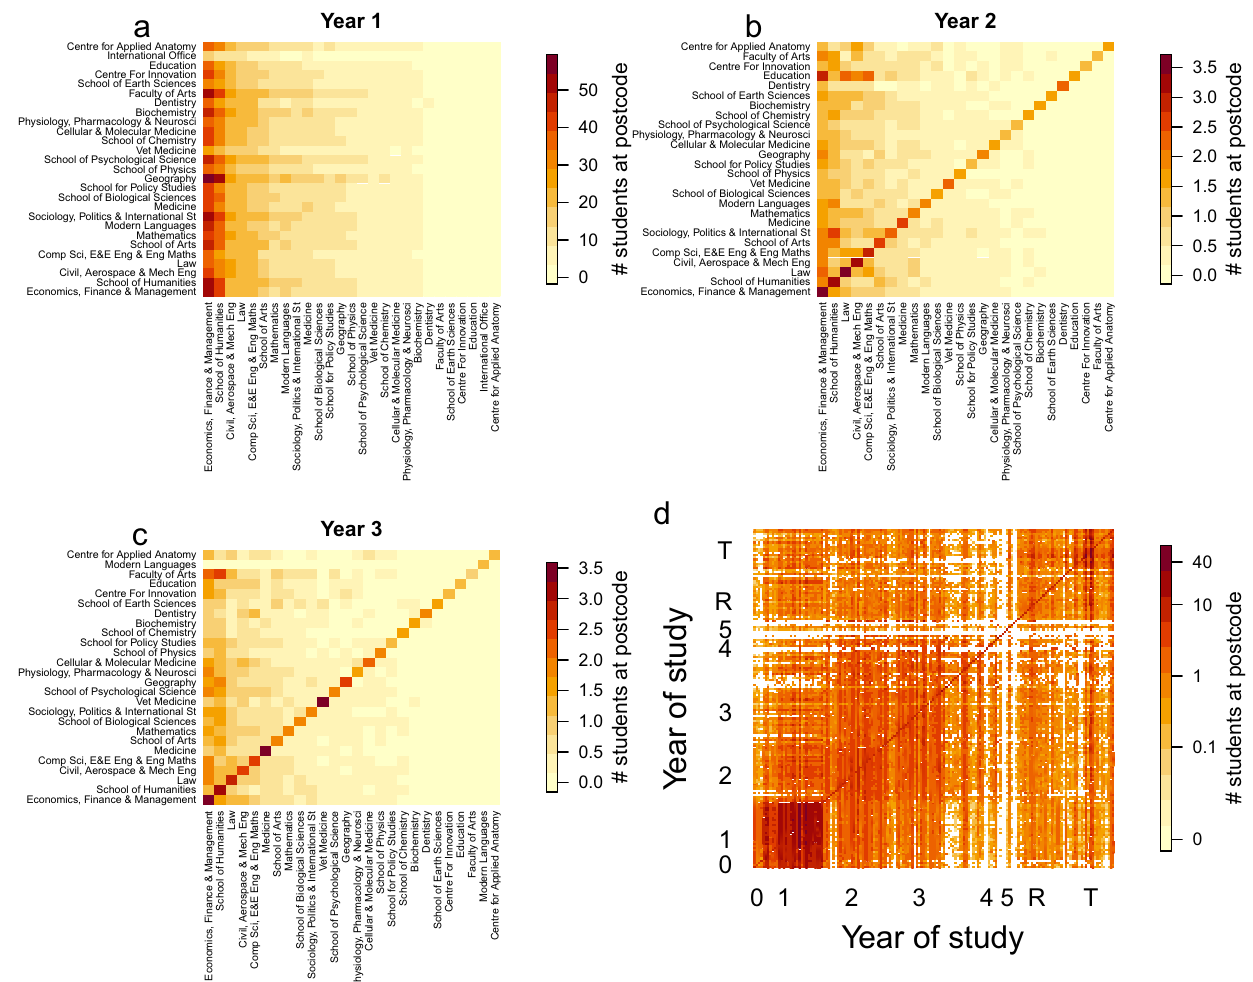
Fig. 1 Student mixing matrices based on shared accommodation. The average number of students in each school sharing accommodation in a year 1, b year 2, c year 3 and d for all years and schools. The years are six undergraduate years: 0, 1, 2, 3, 4, 5 and two postgraduate groups R (research) and T (taught). The columns are ordered by total number of accommodation contacts. Data relate to the University of Bristol for the 2019/2020 academic year.